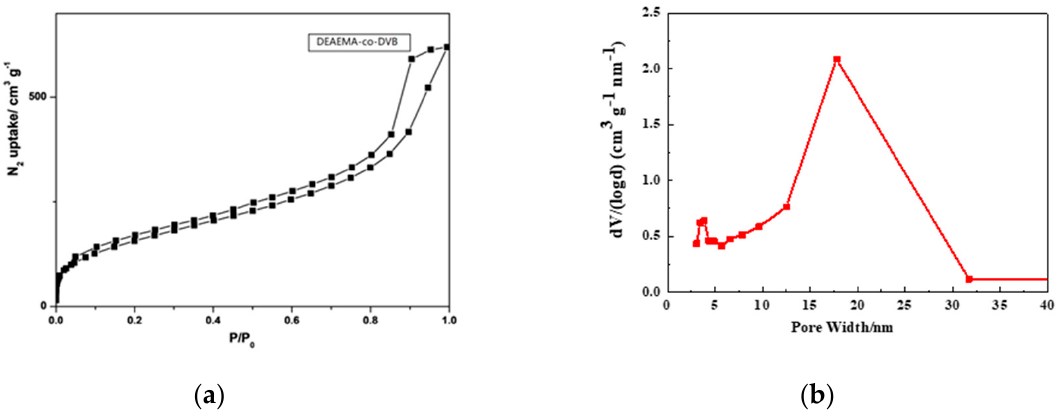
Figure 3. ( a ) N2 adsorption–desorption isotherms; and ( b ) pore size distribution of poly(DEAEMA- co-DVB) microspheres.